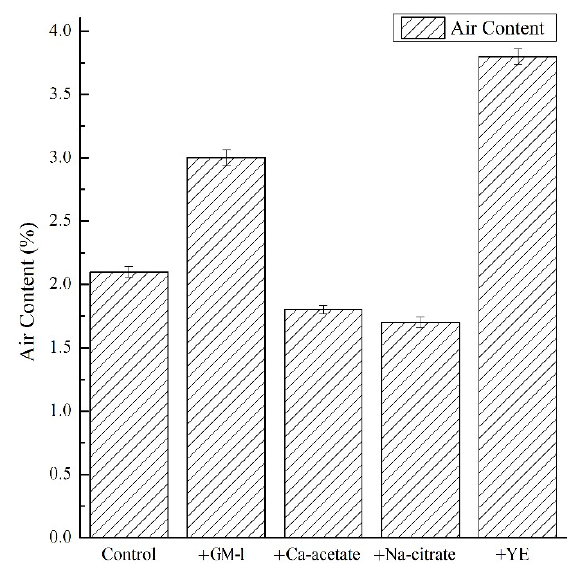
Figure 1. Air content of cement mortars.